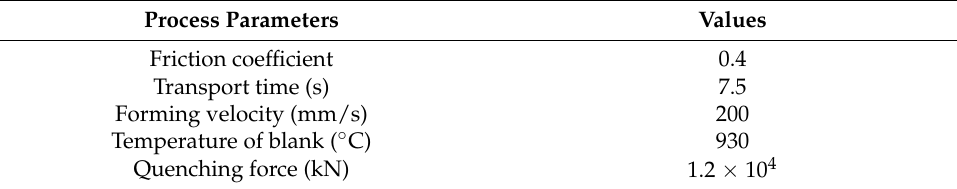
Table 3. Values of process parameters adopted during FE simulation of TTT-press-hardening